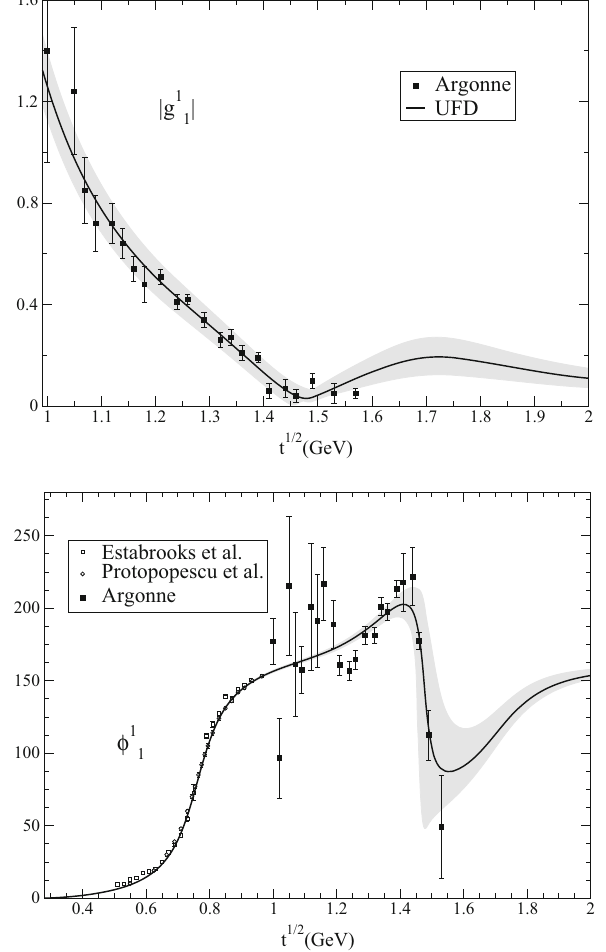
( t ) ππ → K ¯ K partial wave. Fig. 1 Modulus and phase of the g 1 1 The continuous line and the uncertainty band correspond to the UFD parameterization described in the text. Note that the phase below K ¯ K follows that of I = 1 ,(cid:7) = 1 elastic ππ scattering [17]. The white circles and squares come from the ππ scattering experimental analyses of Protopopescu et al. [2] and Estabrooks et al. [4], respectively χ 2 / dof = 1 . 7, but a slightly larger χ 2 / dof = 2 . 2 is found